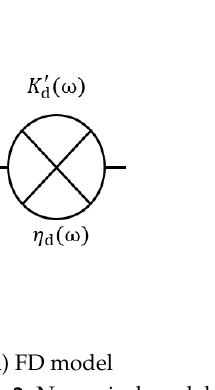
Figure 2. Numerical models of the VE